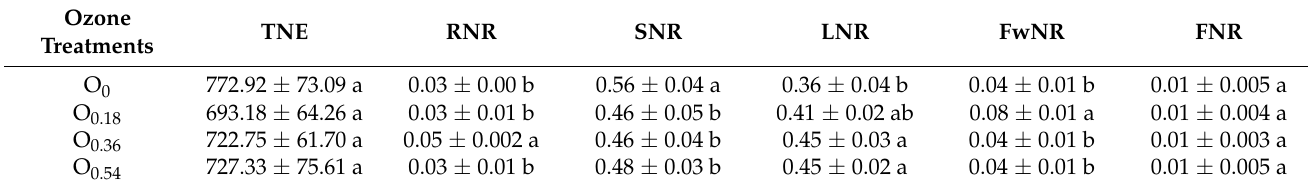
Table 12. Effect of O 3 dosage on total nitrogen extracted by plant (TNE) (mg plant − 1 ) and their distribution in root (RNR), stem (SNR), leaf (LNR), flower (FwNR), and fruit (FNR) (dimensionless). The data recorded are the means ± standard deviation of four samples per treatment at the end of the experimental period. In each column, different letters denote statistically significant changes between treatments (LSD test; p < 0.05).